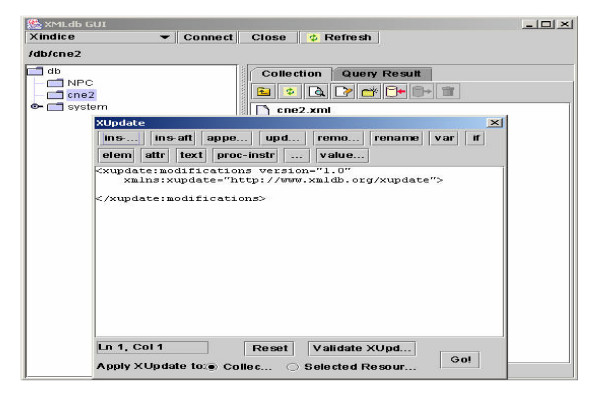
The interface of XUpdate. With the interface of XUpdate in the XMLDBGUI, the data of NPC proteomics repository could be updated easily.